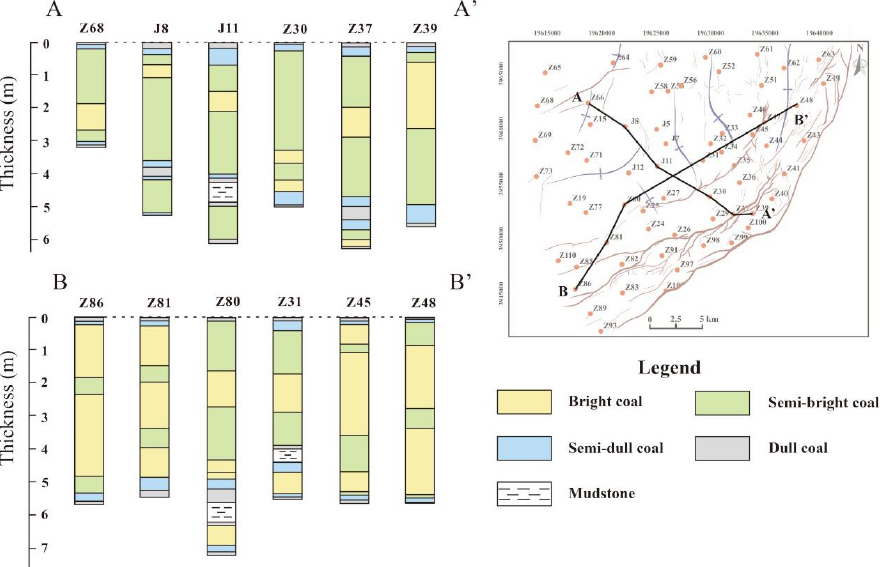
Figure 7. A to A’ and B to B’ cross-sections showing No. 3 seam thickness and macrolithotype identification from the well logging data. The A-A’ cross-section is approximately located along the